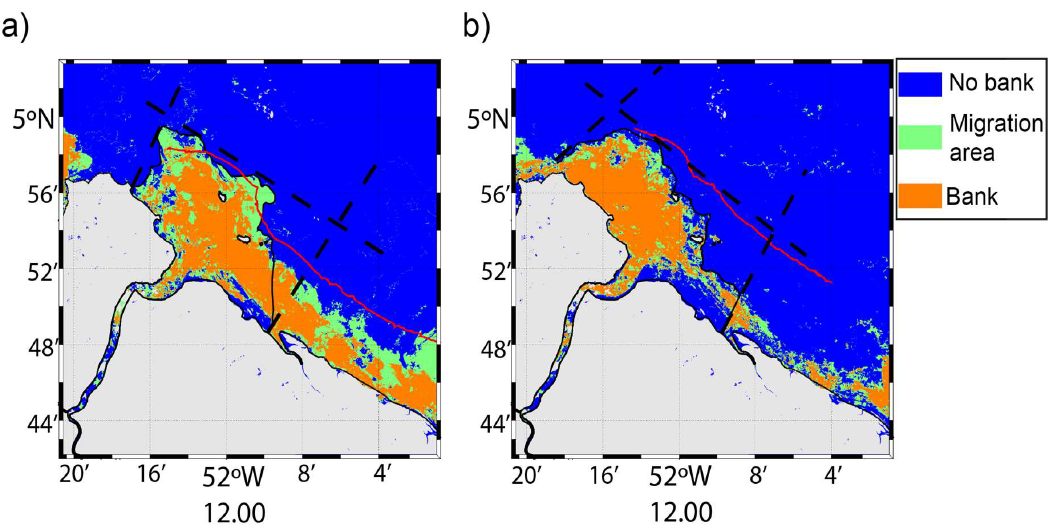
Figure 2. Location of the footprint of the subtidal mud bank estimated using SPM values ( a ) for the rainy season of 2016 and ( b ) for the dry season of 2017. The red line corresponds to the 5 m depth contour and the dashed lines correspond to the leading edge, the back, and the extension of the bank. The black line corresponds to the approximate line that represents the final location used within the framework of this study.